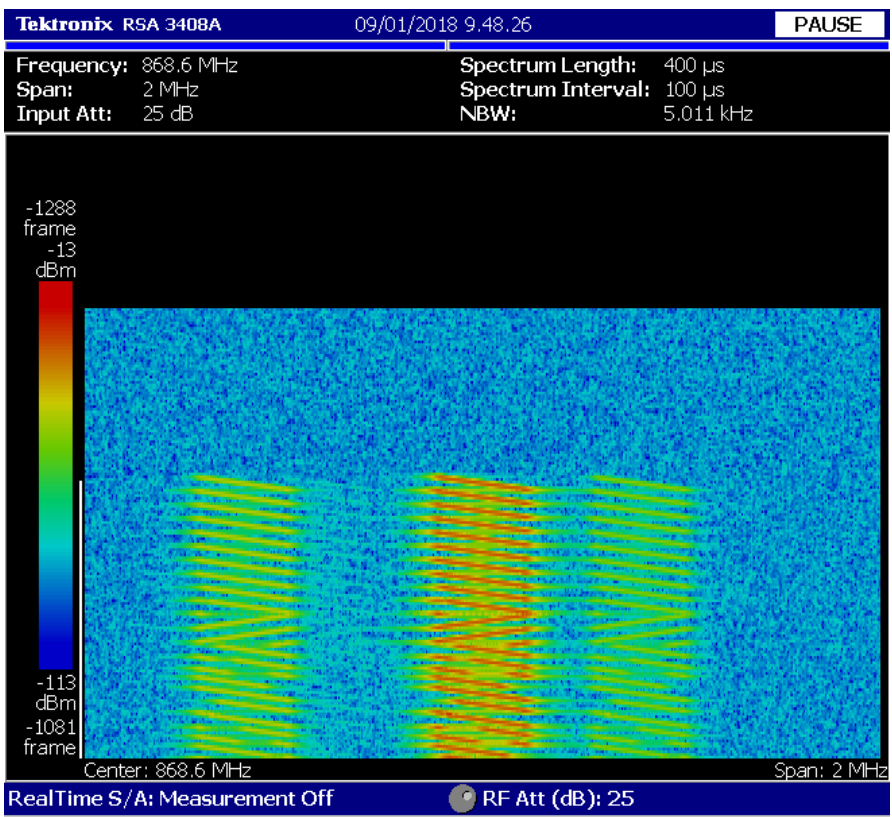
Figure 20. Acquired Blind messages during a fault between PR3 and TR.